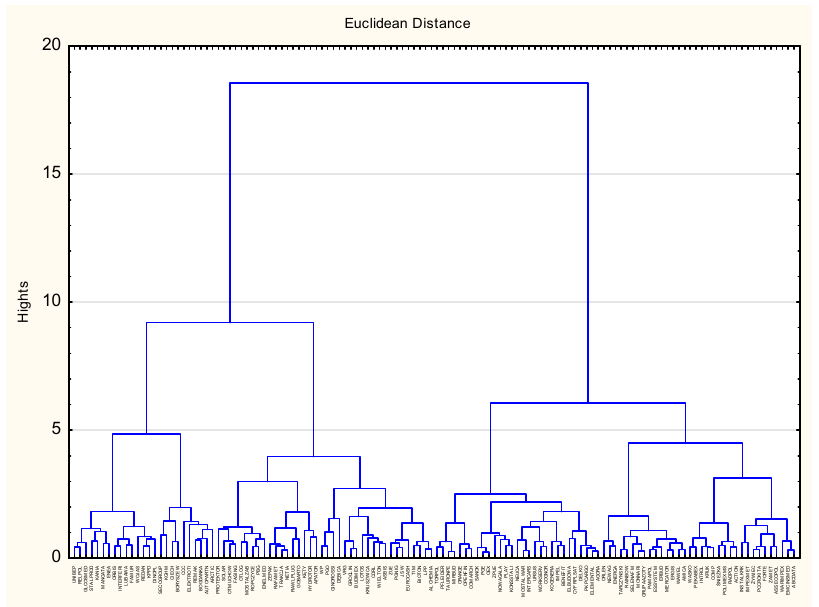
Figure 1. Ward’s cluster dendrogram. Source: own work using STATISTICA software.